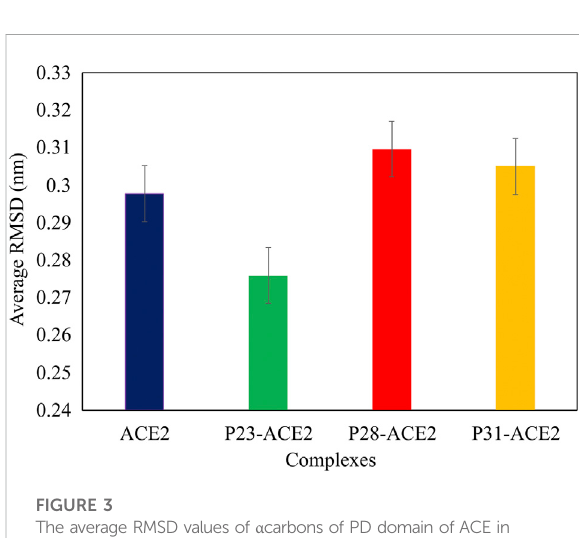
FIGURE 3 The average RMSD values of α carbons of PD domain of ACE in